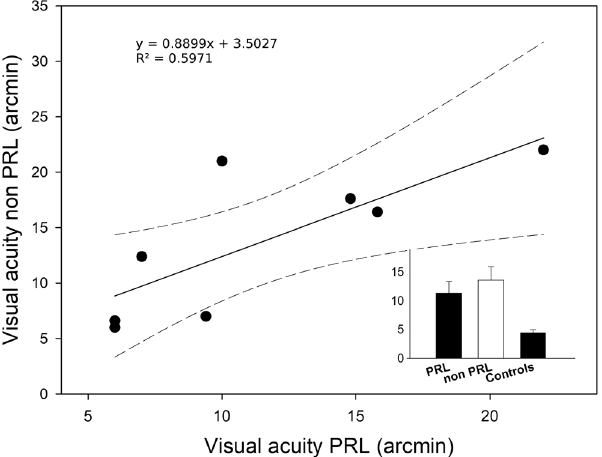
Figure 5. Scatter plot represents visual acuity obtained with stimuli presented at the non-PRL regressed on visual acuity obtained with stimuli presented at the PRL only for the patients for which the two positions were symmetrical with respect to the fovea. Dashed lines represent 95% confidence intervals. Average visual acuity for this subgroup (n = 8), and for the control group (n = 7) is also shown in the bar chart.